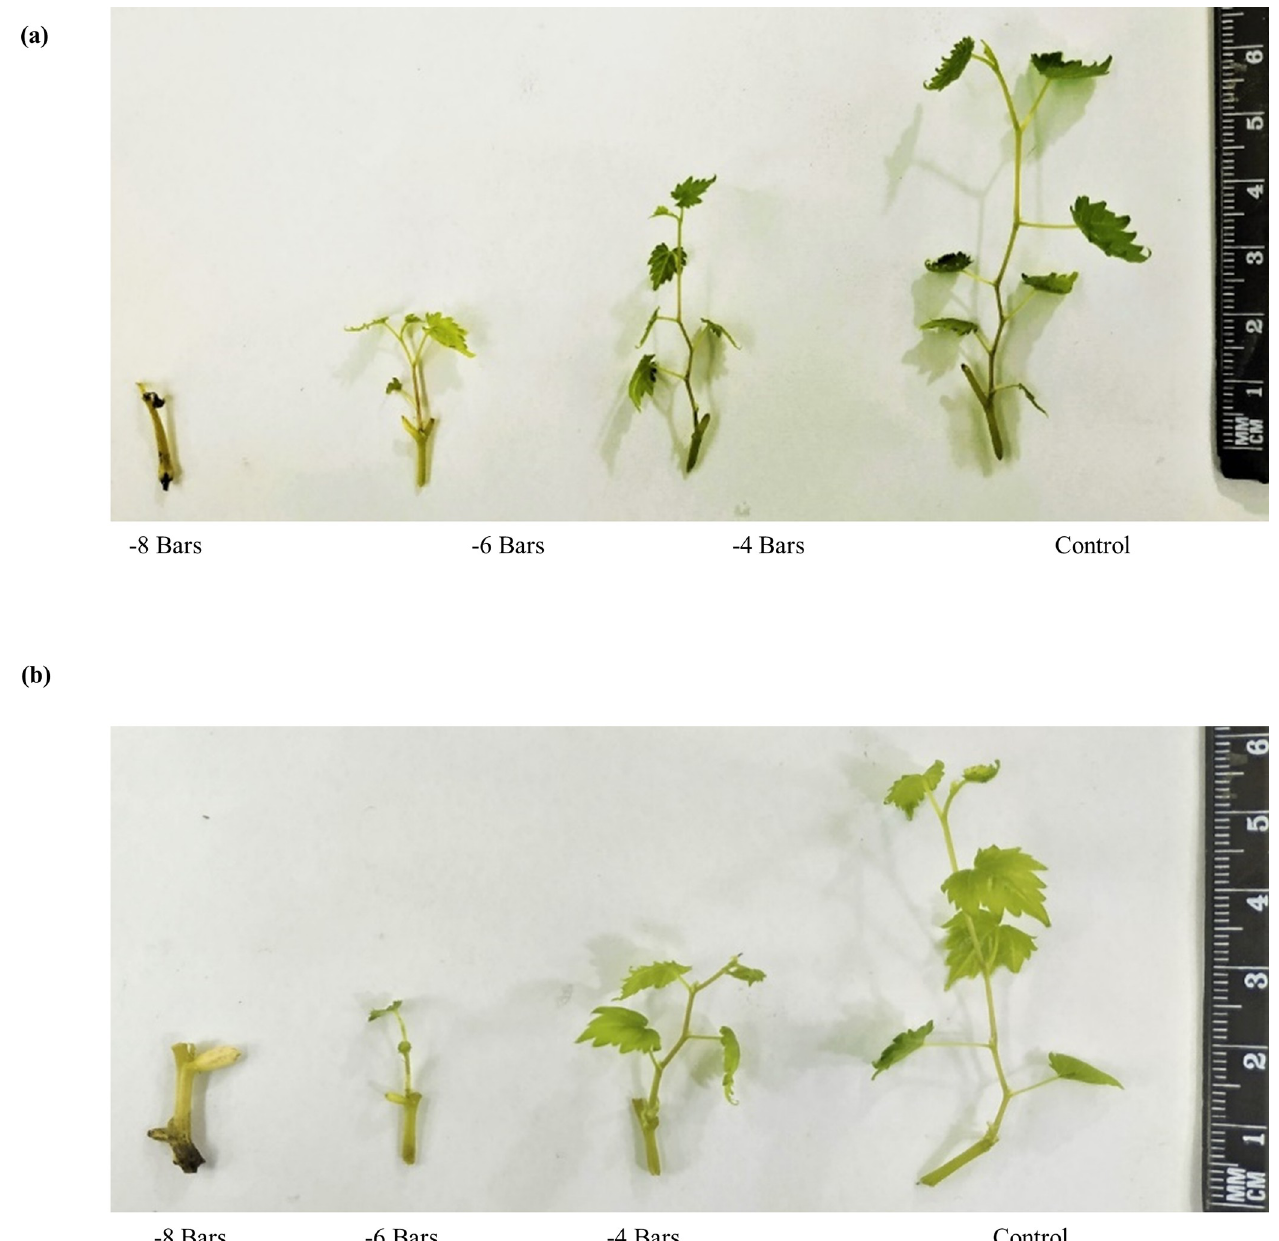
Fig 21. Treated un-grafted commercial scion varieties Kings Ruby (a) and Flame Seedless (b).